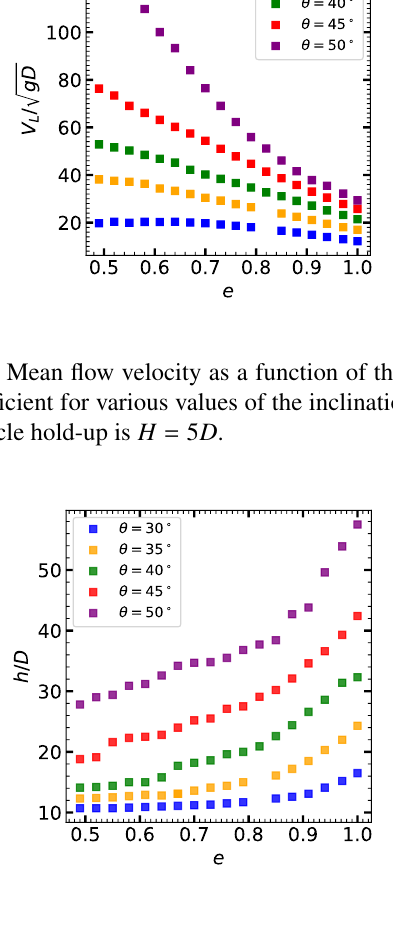
Figure 4: Flow height h as a function of the restitution coe  cient for various values of the inclination angle. The particle hold-up is H = 5 D .